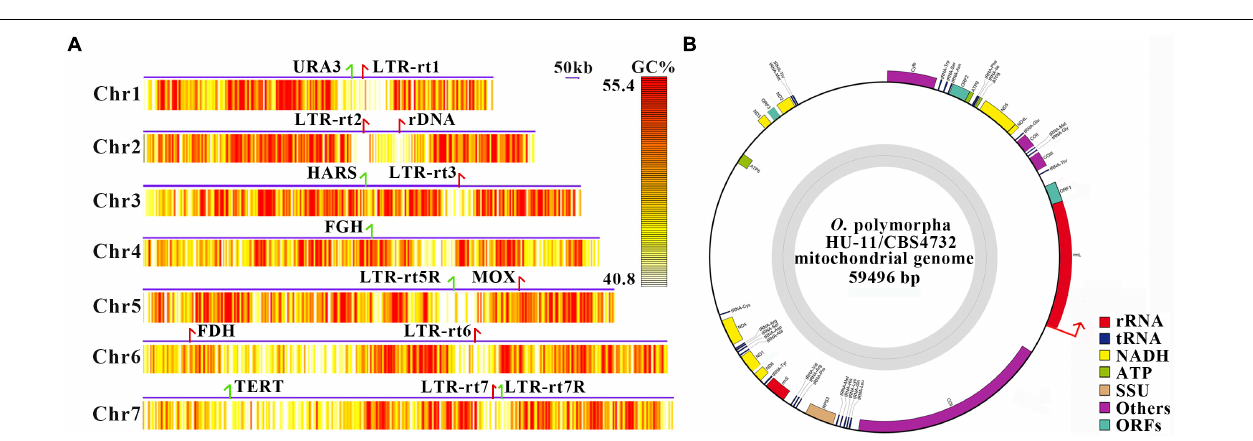
Frontiers in Microbiology |